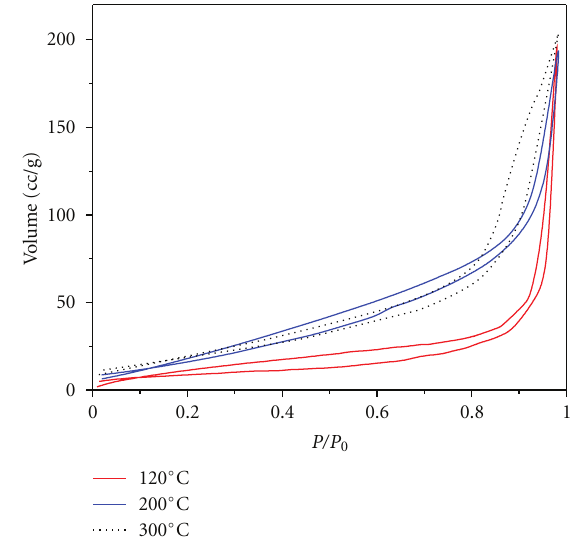
F 4: Adsorption-desorption isotherm using N samplescuredwithUVanfurtherannealingatdifferent temperatures.